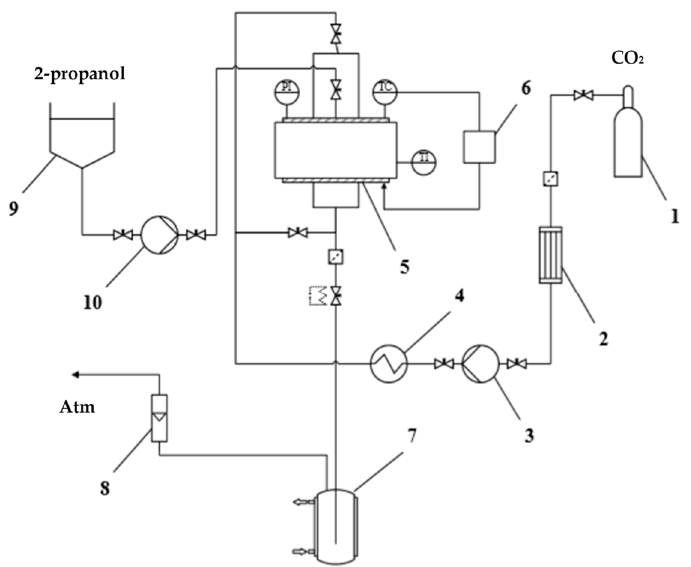
Figure 7. Schematic diagram of the setup for supercritical processes.